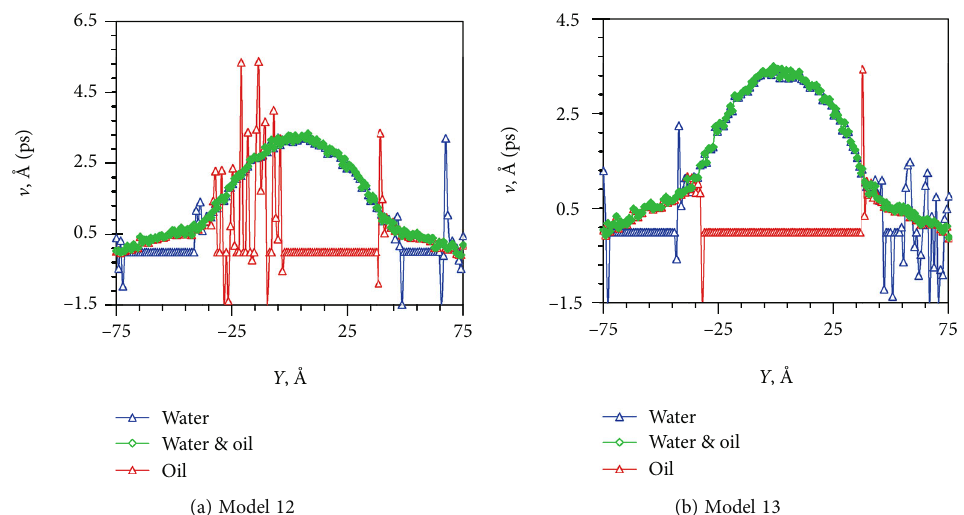
Figure 14: Velocity pro fi le along the X -axis of models of di ff erent temperature.